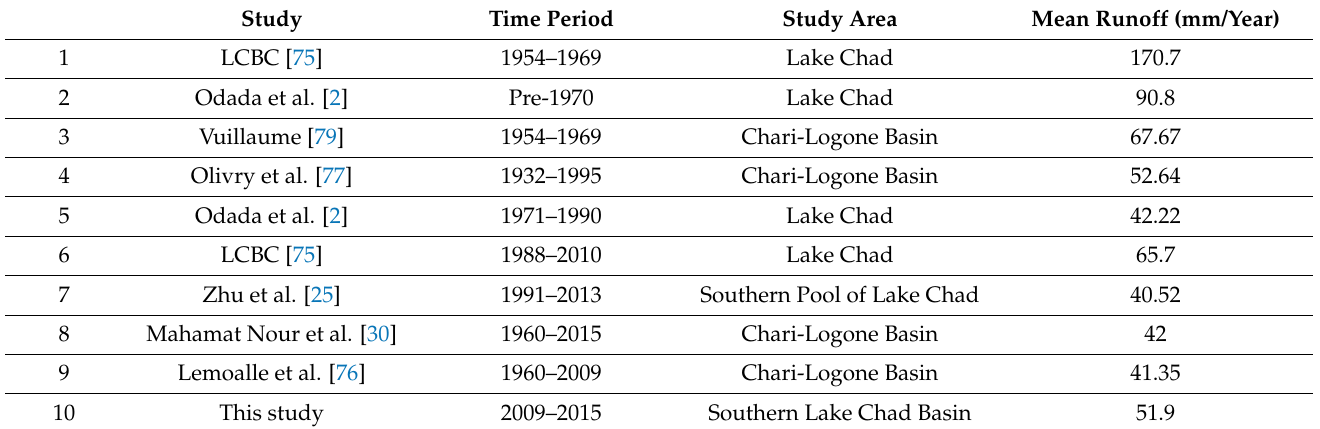
Table 10. Comparison of water budget components estimated in Lake Chad Basin in different